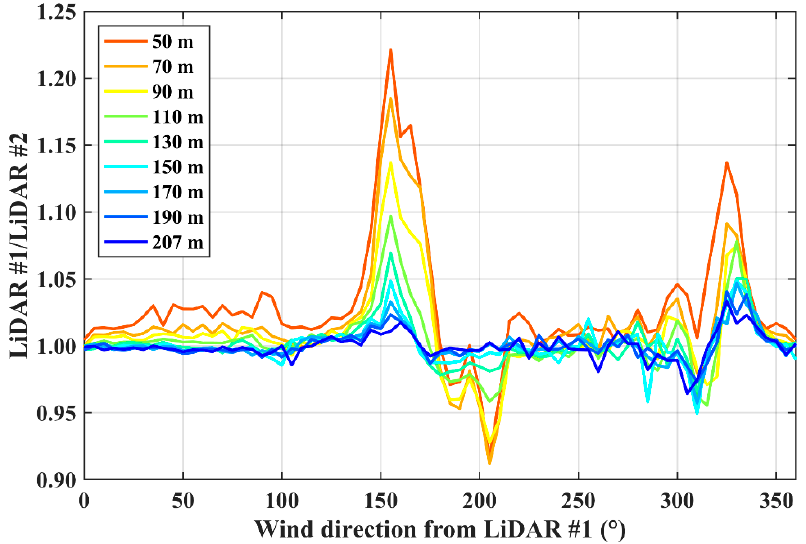
Figure 11. Bin-averaged LiDAR #1 to LiDAR #2 wind speed ratio as a function of wind direction at heights of 50, 70, 90, 110, 130, 150, 170, 190, and 207 m ASL.